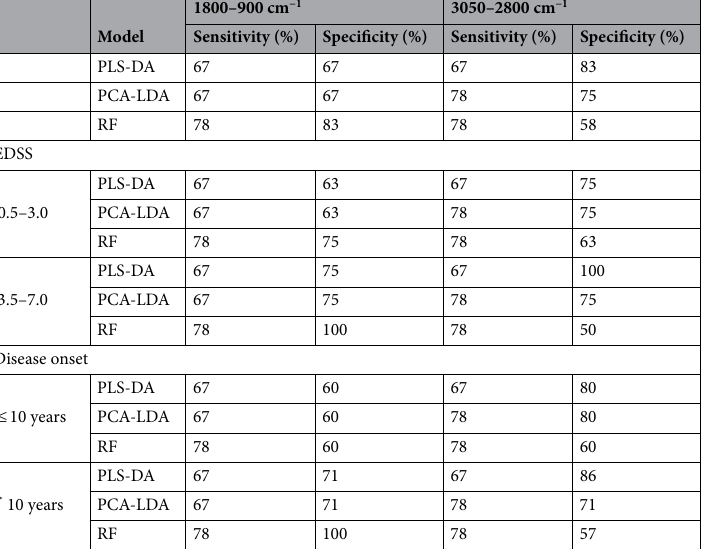
Table 2. Sensitivity and Specificity for the chemometric models for either the MS group as a whole or separated in subgroups with different EDSS values or disease onset in the two spectral regions, 1800–900 cm −1 and 3050–2800 cm −1